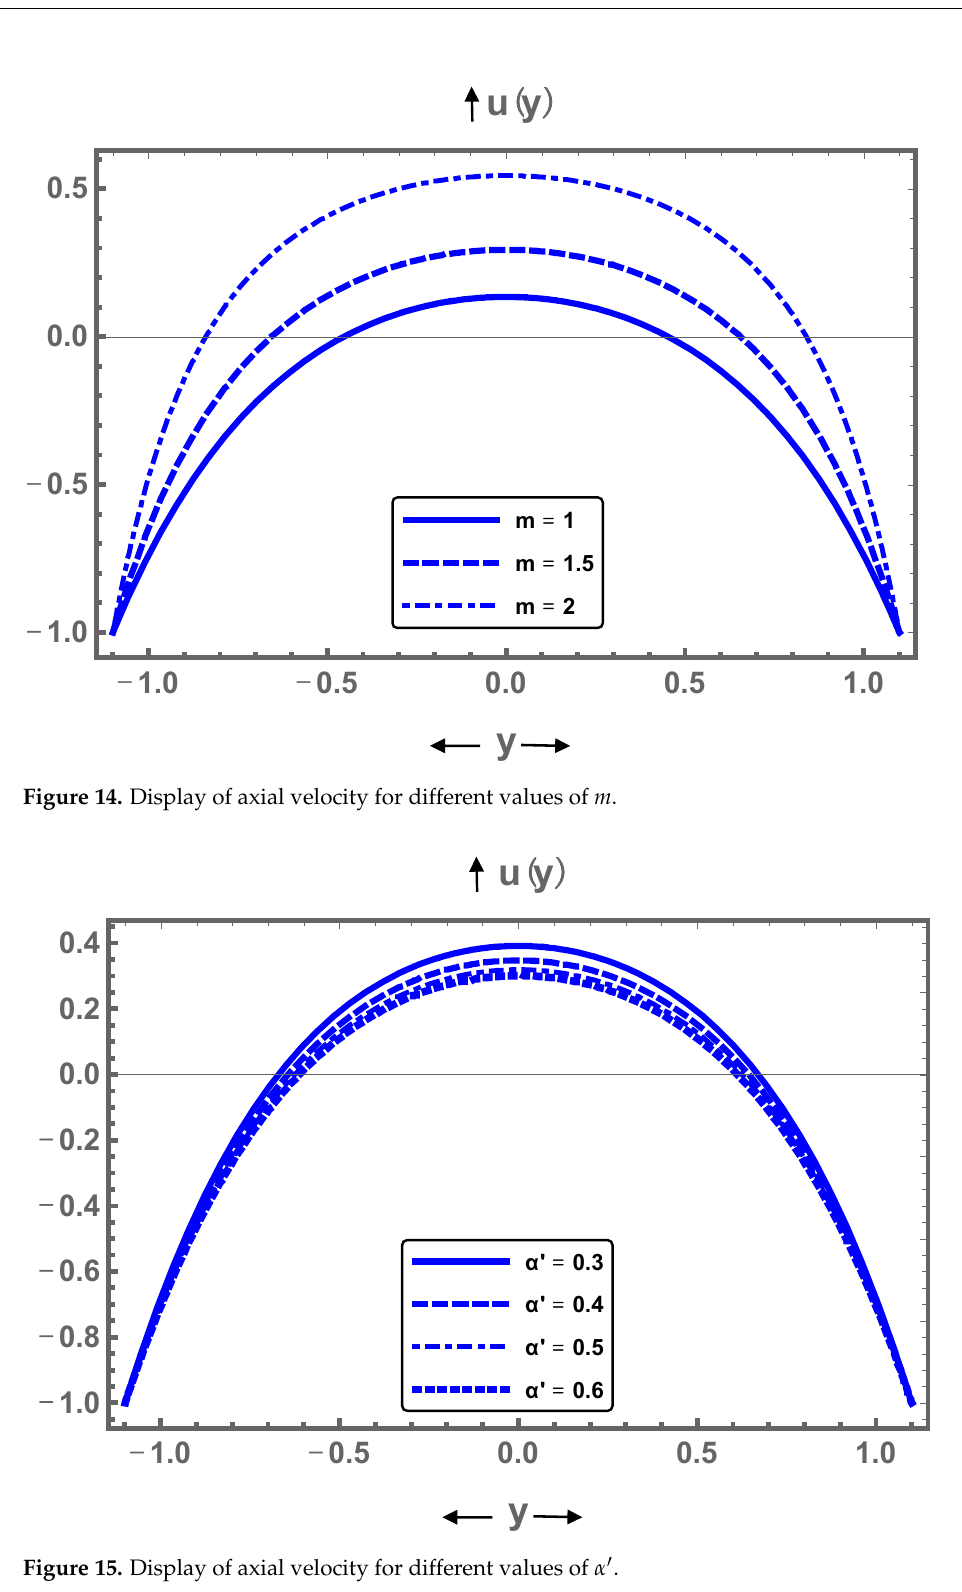
Figure 15. Display of axial velocity for different values of 𝛼 (cid:4593) .